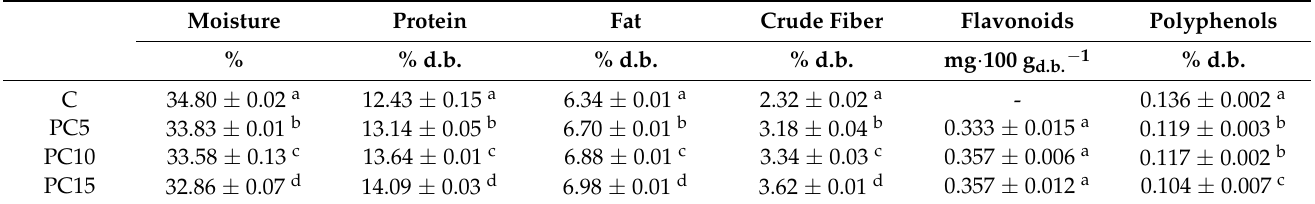
Table 2. Chemical compositions of oatmeal cookies with poppy seed expeller added ( n = 3). Moisture